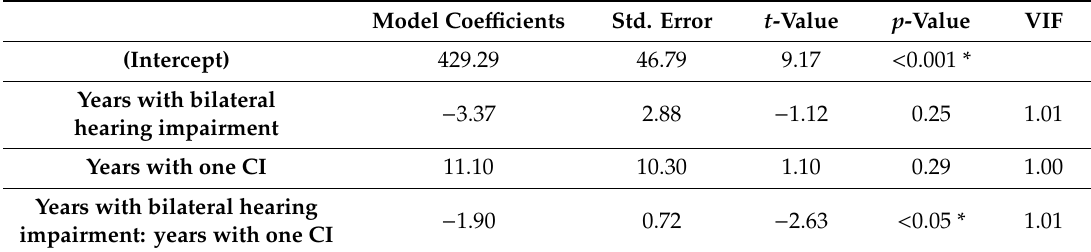
Table 5. Model coe ffi cients and p -values for ITD JND model. Asterisks denote the significant predictors. Model Coe ffi